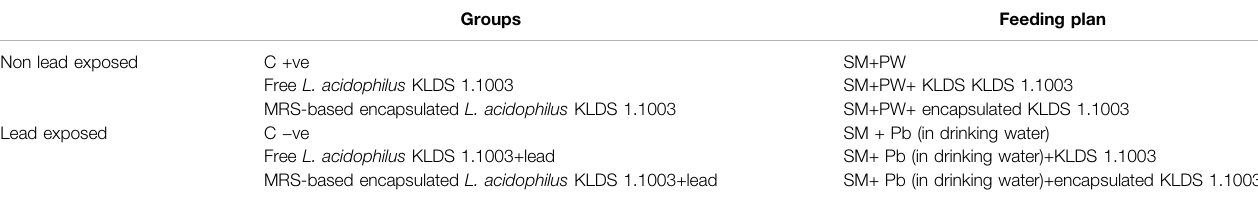
TABLE 1 | Protocols for the animal experiment. Groups Feeding